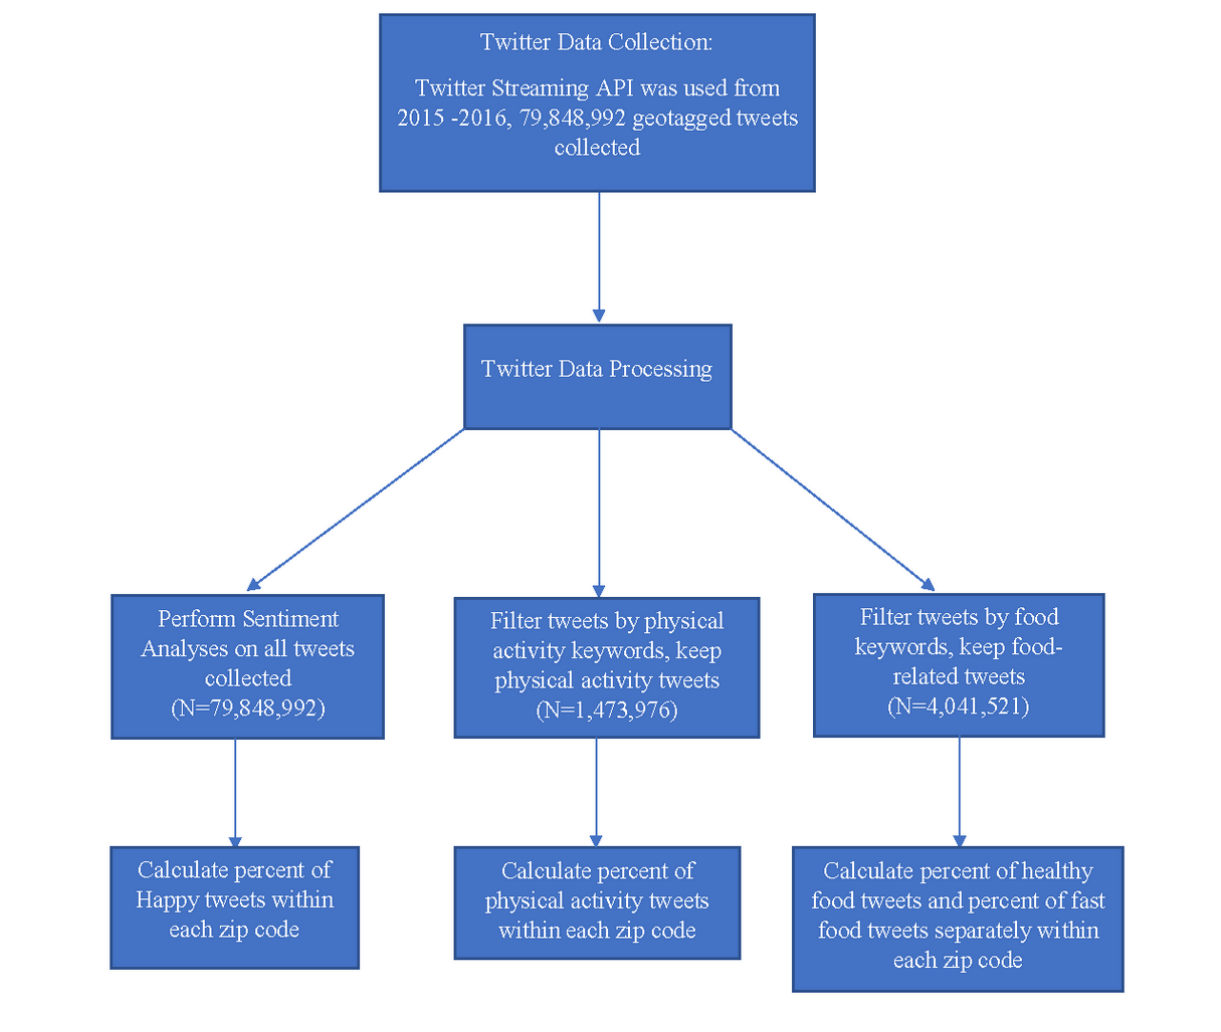
Figure 1. Twitter data collection and construction of Twitter